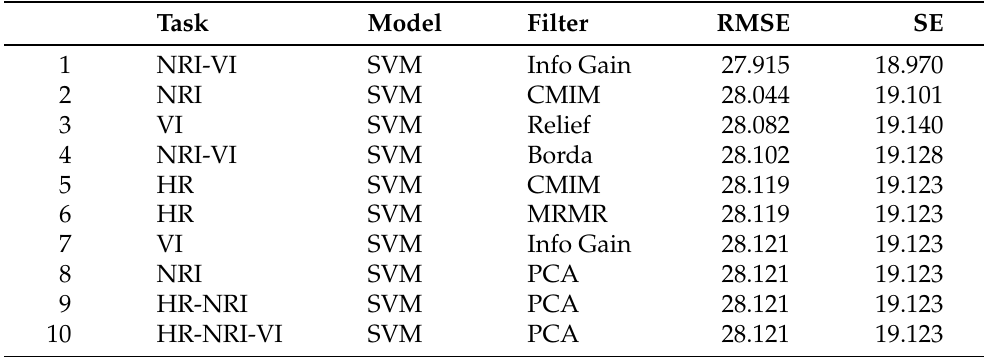
Table 5. Best ten results among all learner–task–filter combinations, sorted in decreasing order of RMSE (p.p.) and their respective standard error (SE).